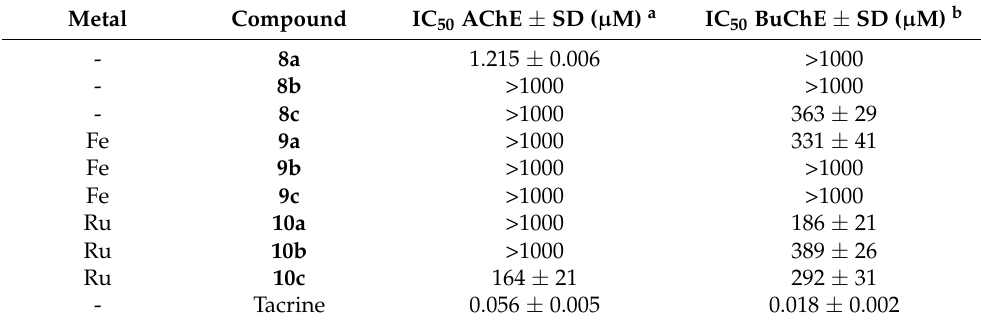
Table 1. Inhibitory effects of compounds 8a – c , 9a – c , 10a – c against AChE and